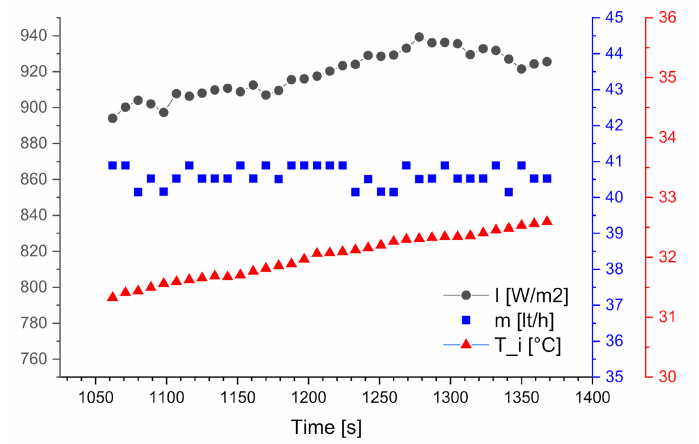
Figure 13. Steady state performance of the radiation, flow rate and inlet